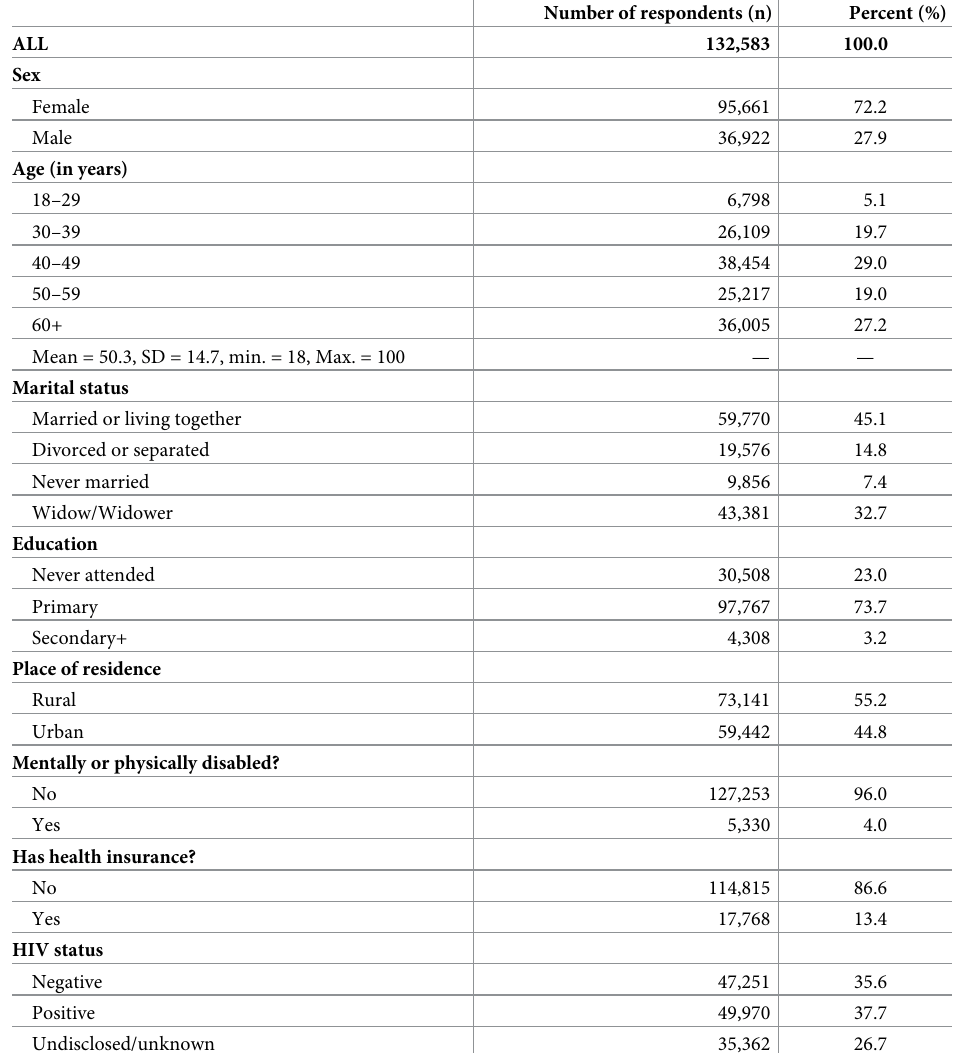
Table 1. Caregivers’ baseline characteristics (n =